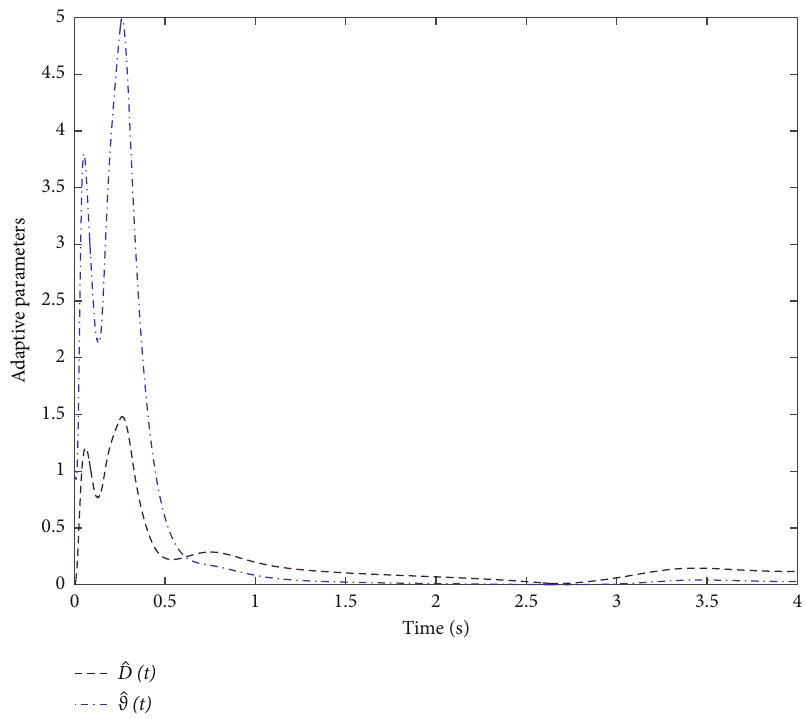
( t ) under NN-AC, DOBC, and proposed 2